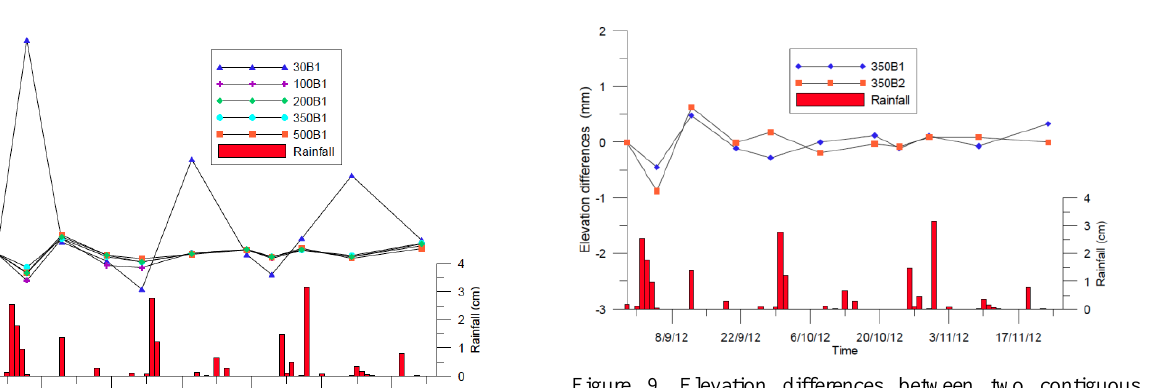
Figure 9. Elevation differences between two contiguous